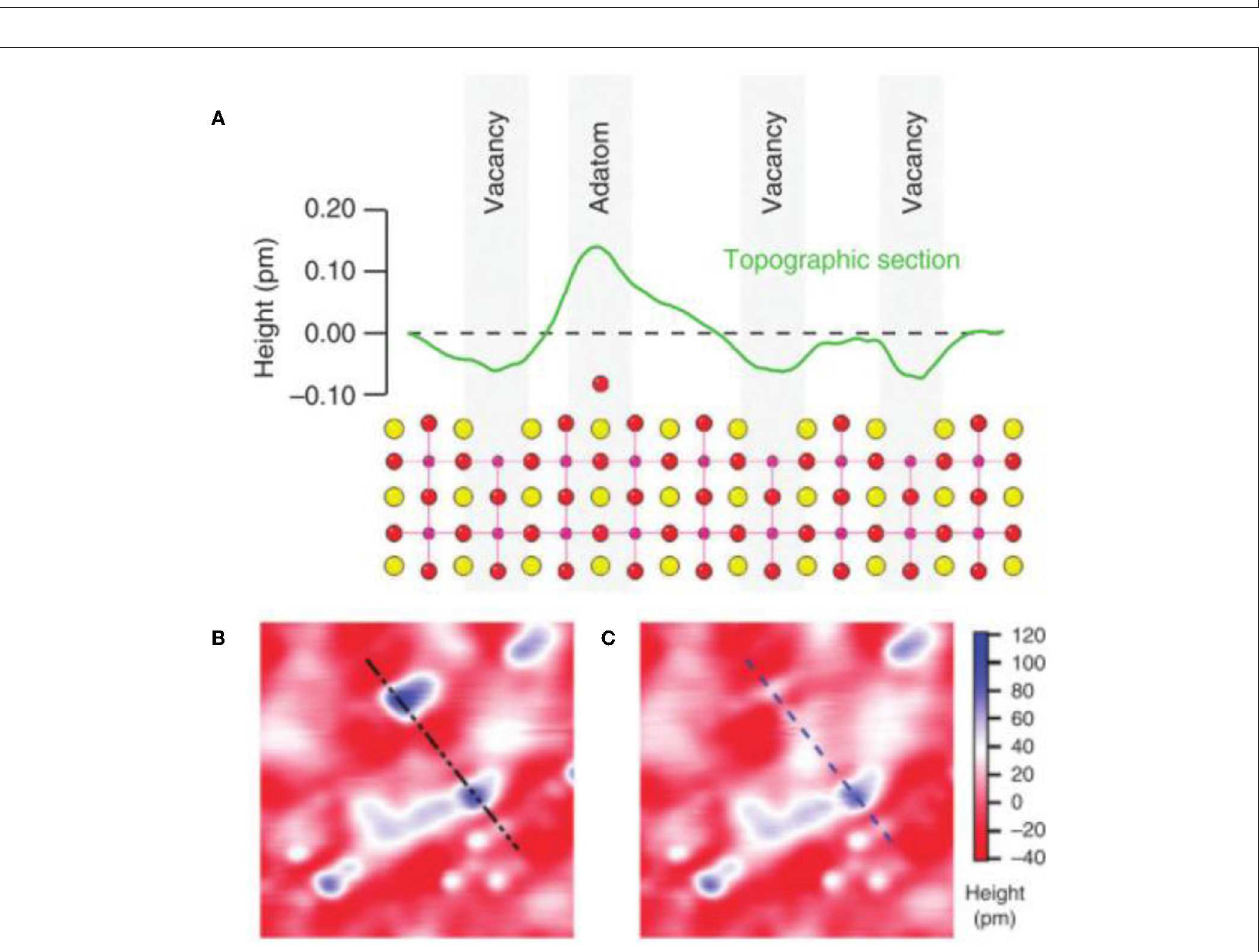
used to probe the local structure of diverse materials (Montini et al., 2009; Tiseanu et al., 2014). It is reasoned that the intense 5 D → 7 F 0 0 transition of Eu(III) ions can be mainly used in